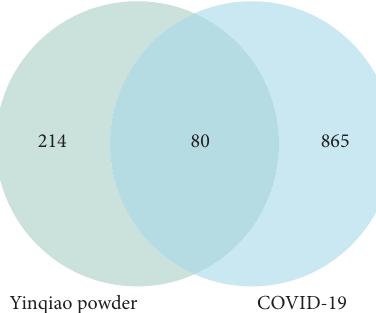
Figure 2: Venn diagram analysis of Yinqiao powder and COVID-